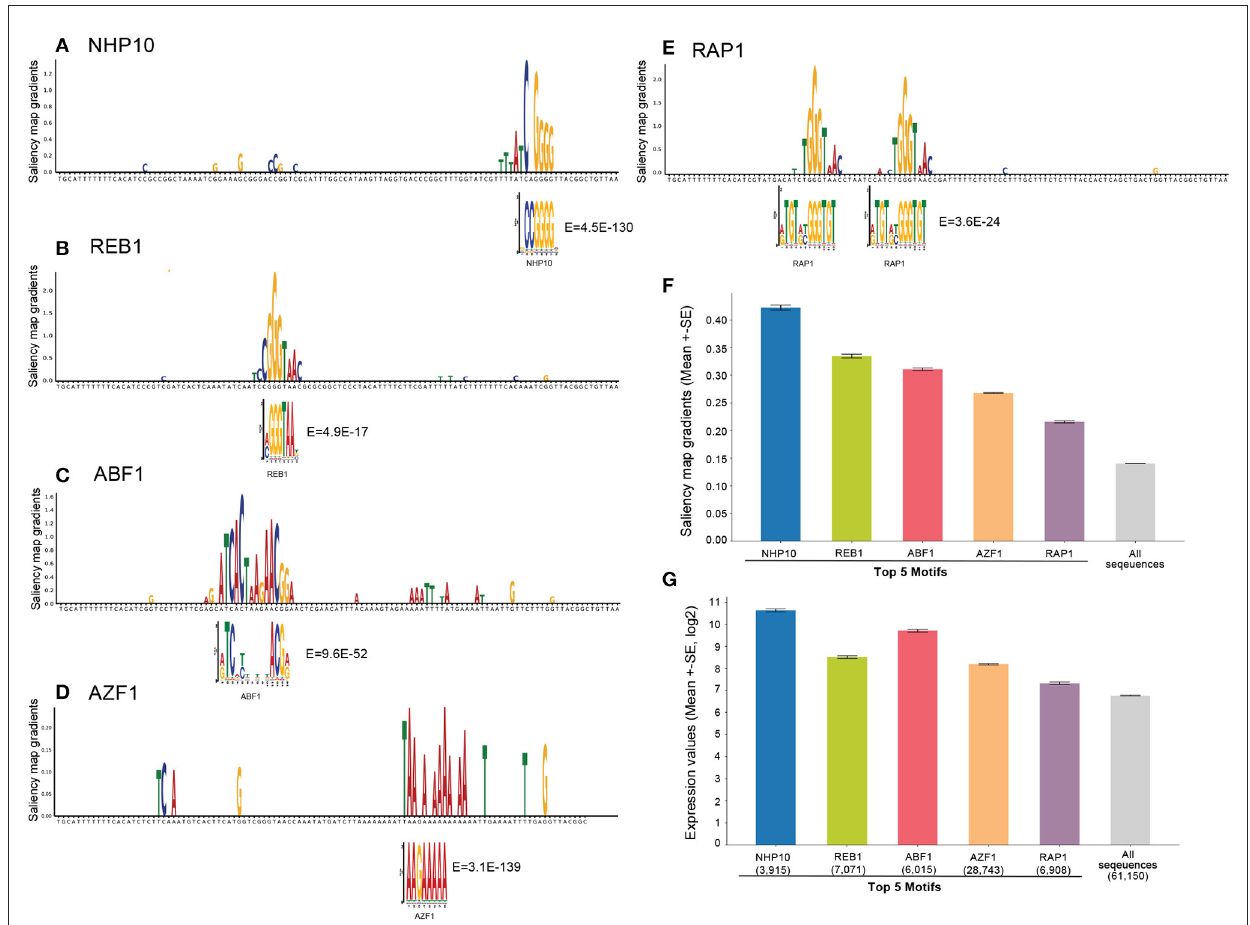
FIGURE5 Model interpretation by saliency maps. (A–E) The top 5 yeast TFBS motifs detected by motif discovery: NHP10, REB1, ABF1, AZF1, and RAP1. Shown is an example sequence with its saliency map gradients over 80-nt for each motif, aligned with the known TF motif logo and E -values. (F) Mean saliency map gradients over these top 5 motif matches in yeast native sequences, and mean saliency map gradients over all sequences as the controls. (G) Mean expression levels of yeast native sequences containing these top 5 TF motifs, and all native sequences as the